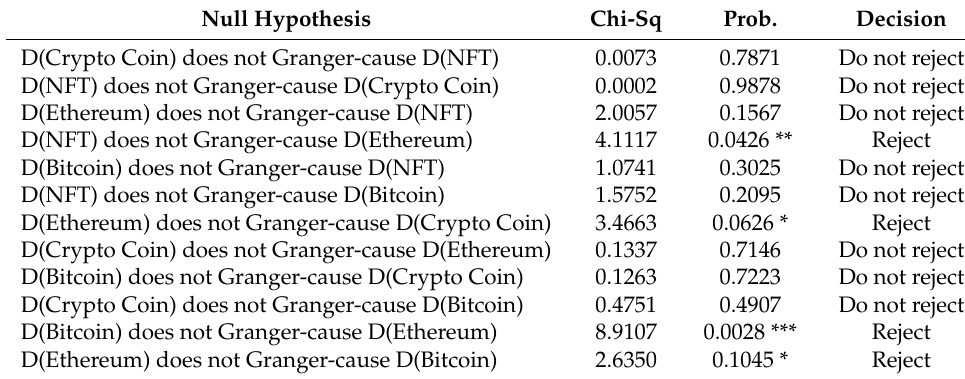
Table 7. Granger Causality Test.